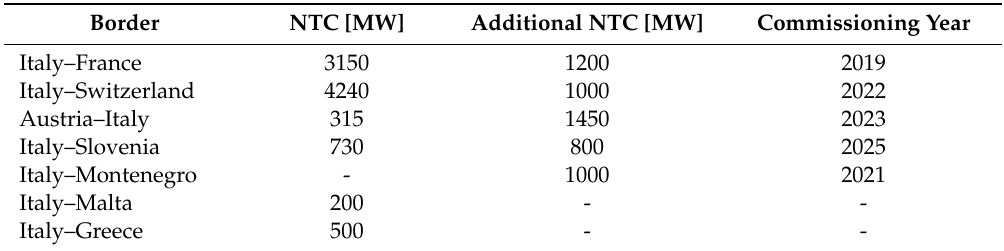
Table 3. Existing and scheduled interconnection capacity between Italy and neighbouring countries [54]. NTC, net transfer capacity.